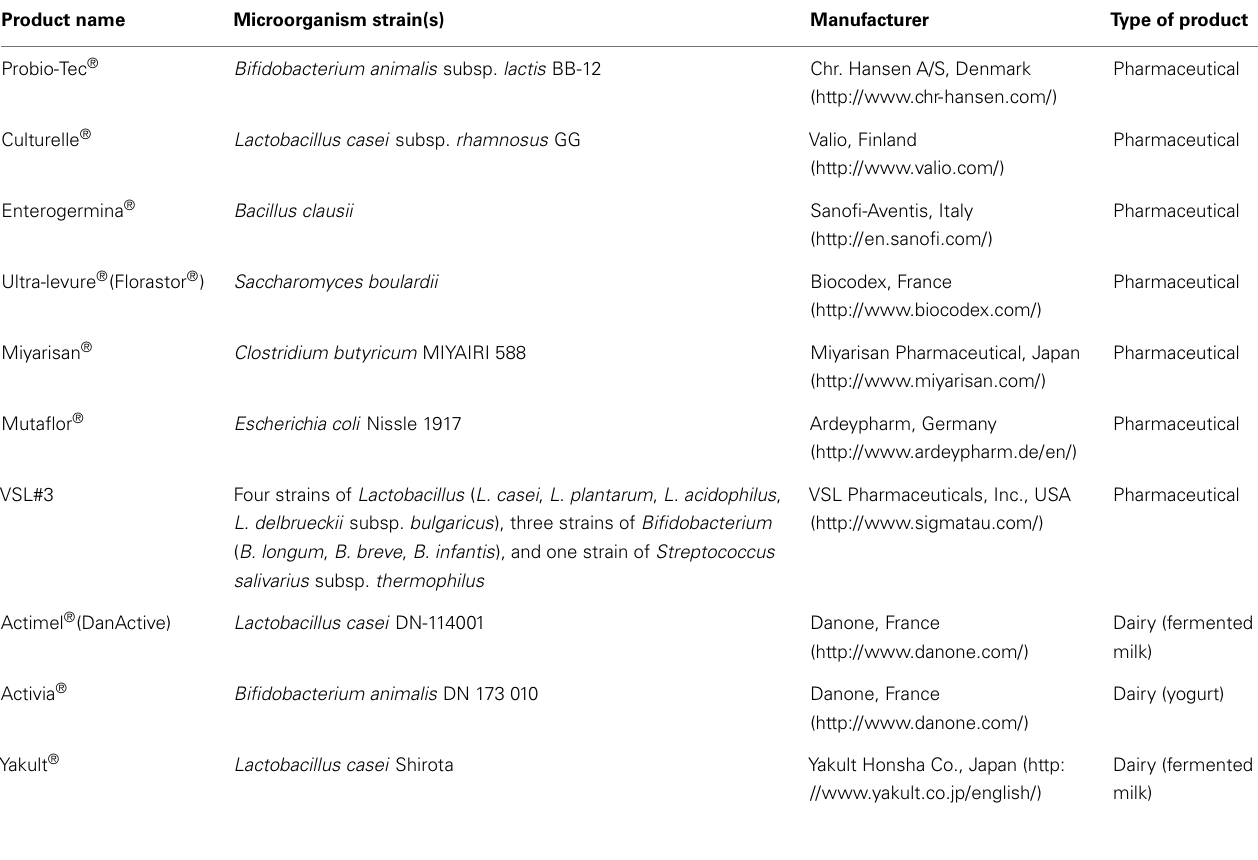
Table 1 | Main manufactured probiotic products commercialized worldwide for human